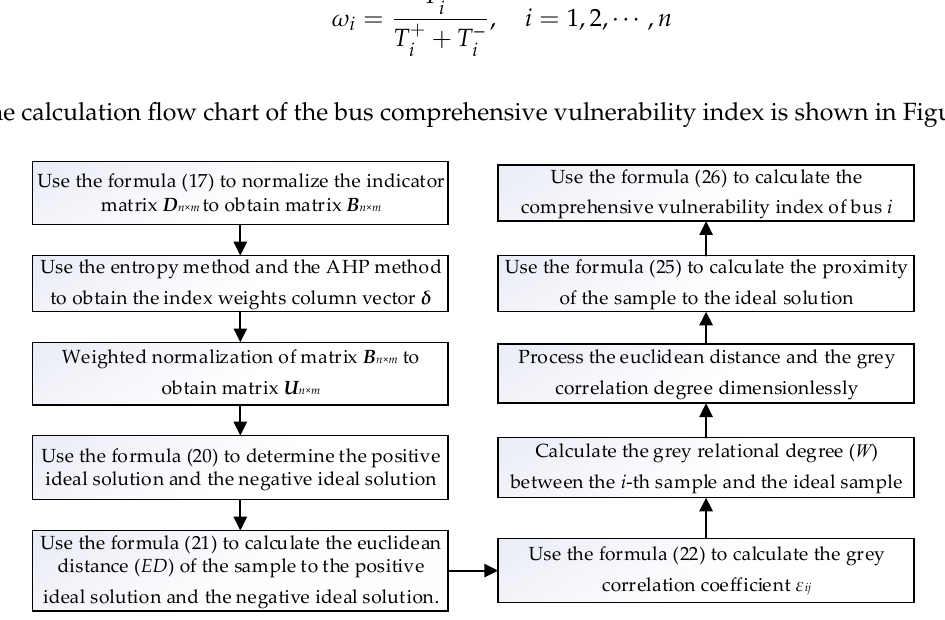
Figure 1. Calculation flow chart of the bus comprehensive vulnerability index.